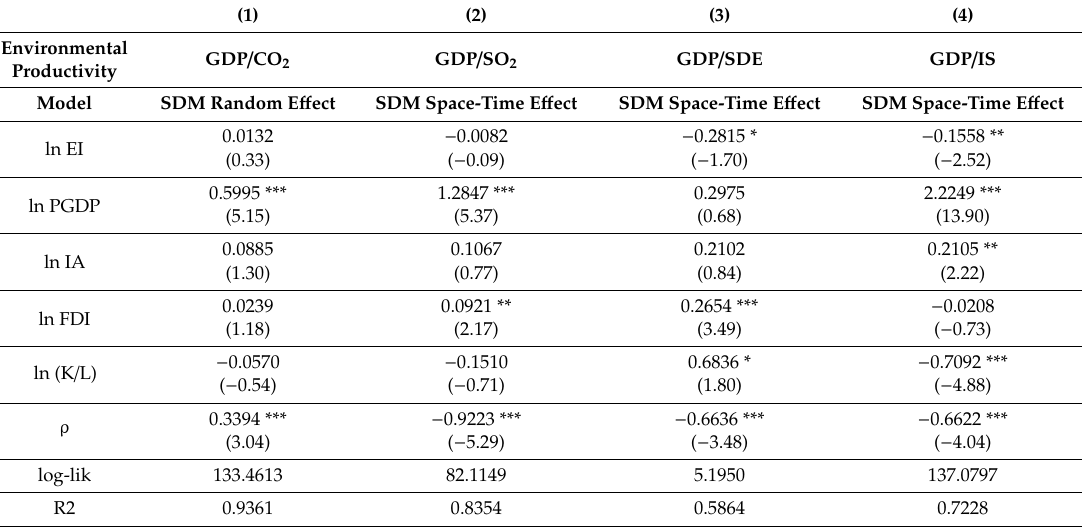
Table 9. Panel data model estimation